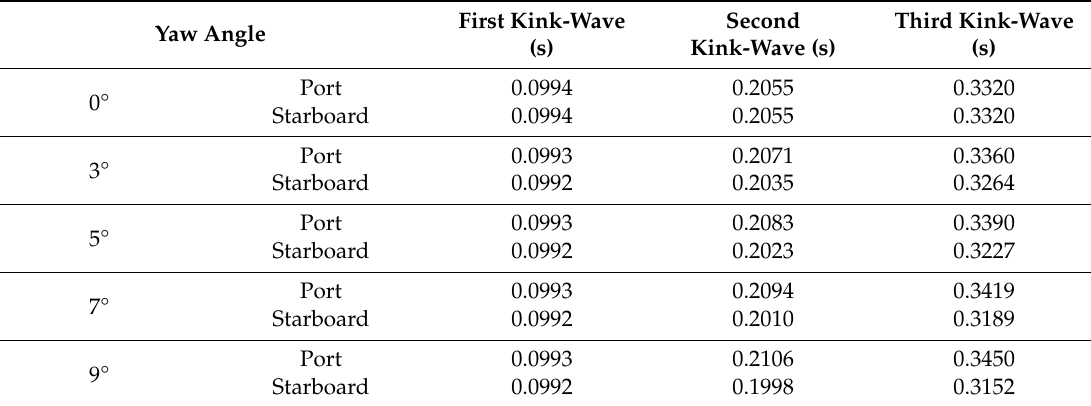
Table 2. Time length comparison of kink-wave in yaw arrest.